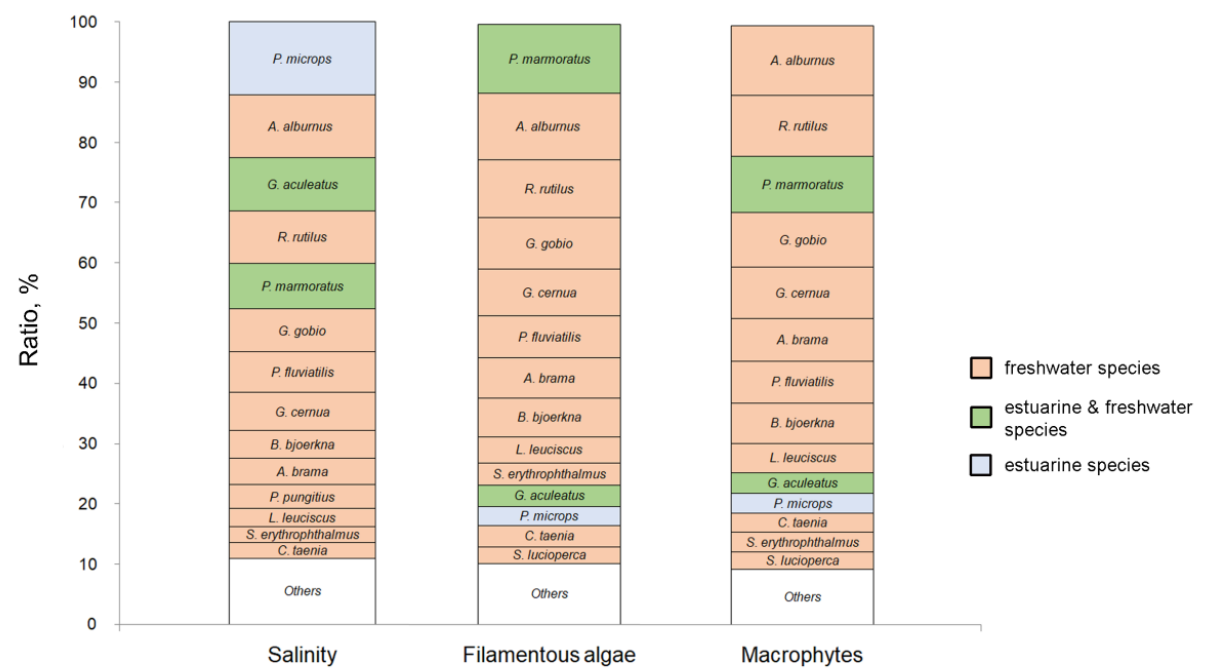
Figure 5. Discriminating taxa by the results of SIMPER for three environmental factors. The contribu- tion of each species to the dissimilarity between groups of samples within each factor is arranged descending. Filamentous algae and Macrophytes represent the data within salinity ≤ 1.9‰.